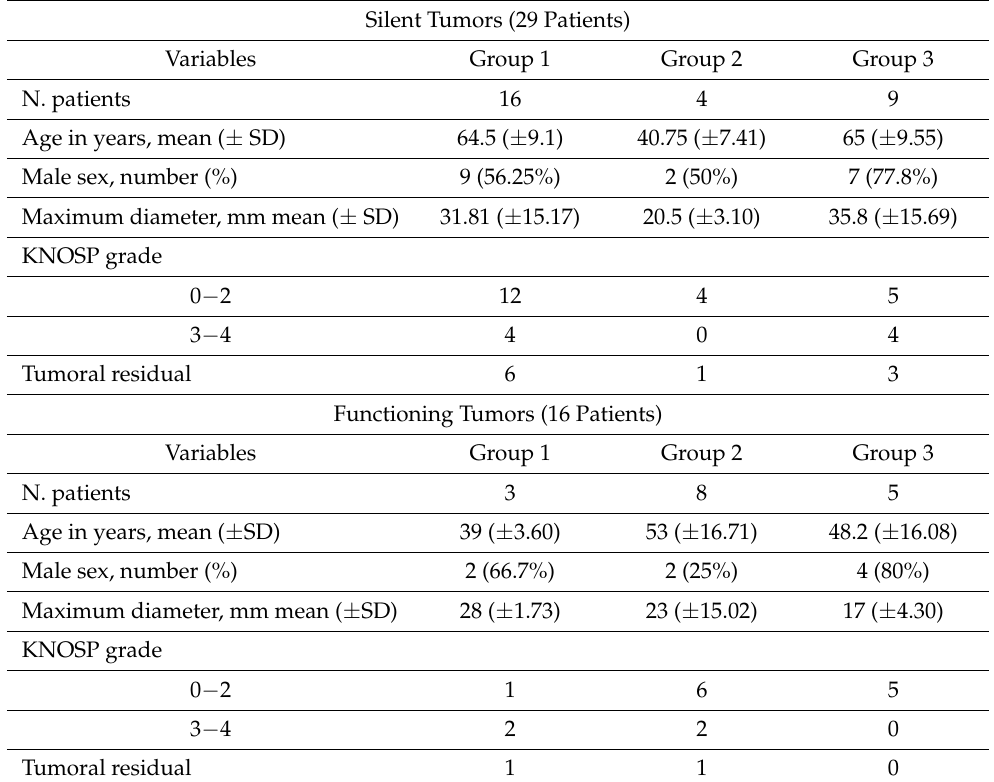
Table 5. Features’ description for silent tumors and functioning tumors’ patients subclassified into three groups according to postoperative pituitary gland